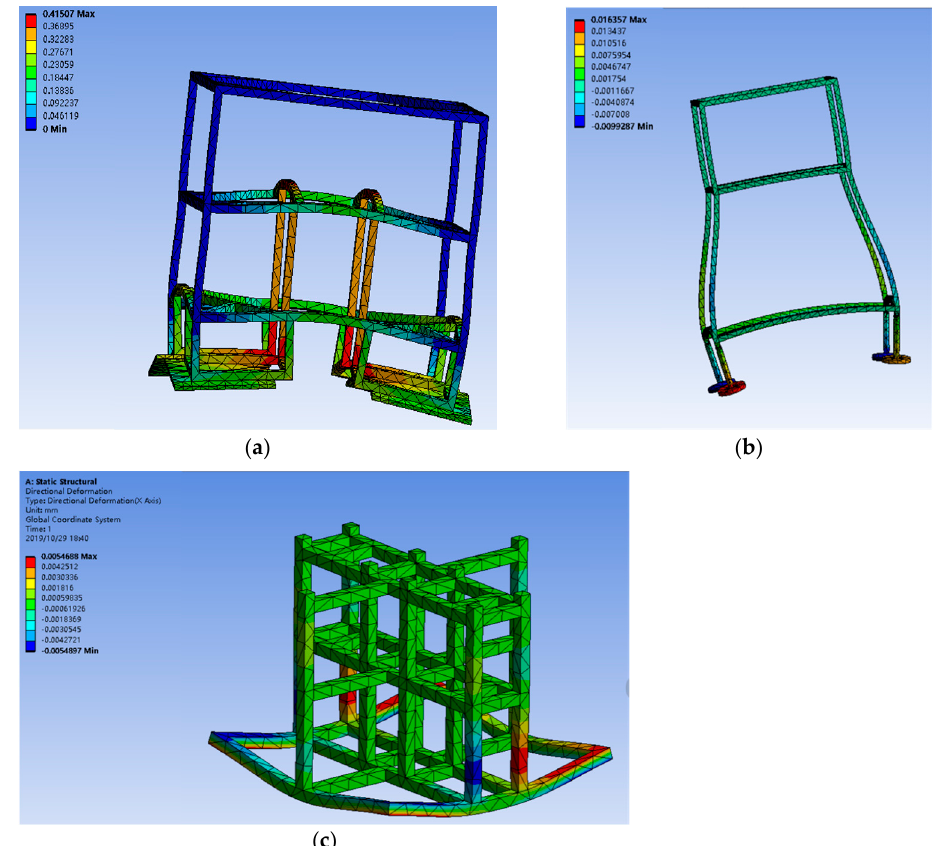
Figure 8. Strain cloud diagram of each kind of frame: ( a ) strain cloud diagram of the deep-sea in situ observatory; ( b ) strain cloud diagram of the “Tianya” abyss lander; ( c ) strain cloud diagram of the benthic lander.